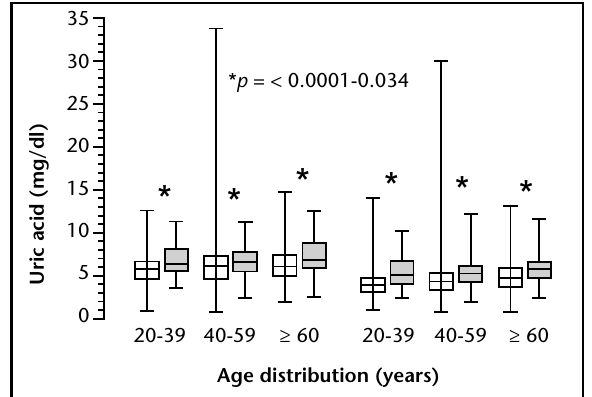
Figure 3 – Serum uric acid in men (left block of comparisons) and women (right block of comparisons) with (dark boxes) and without (white boxes) the laboratory profile of metabolic syndrome, according to age distribution * p -values for the comparisons between subjects with and without the laboratory profile of MS in each age range (Mann-Whitney test). The data are expressed as median(interquartile